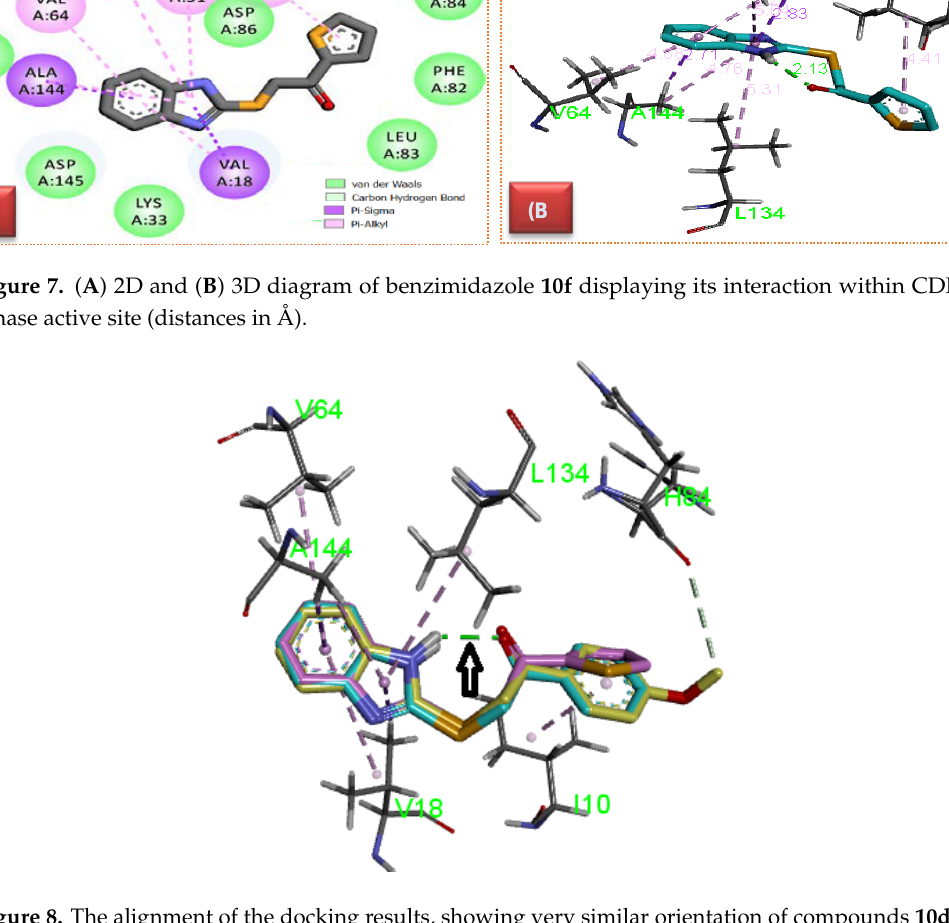
Figure 8. The alignment of the docking results, showing very similar orientation of compounds 10d – f , which are stabilized by an intramolecular hydrogen bond, pointed by black arrow. The 10d is in cyan, 10e is in yellow, and 10f is in pink. Table 5. The interaction energy and bonding between benzimidazoles 10d – f and the CDK2 active site.